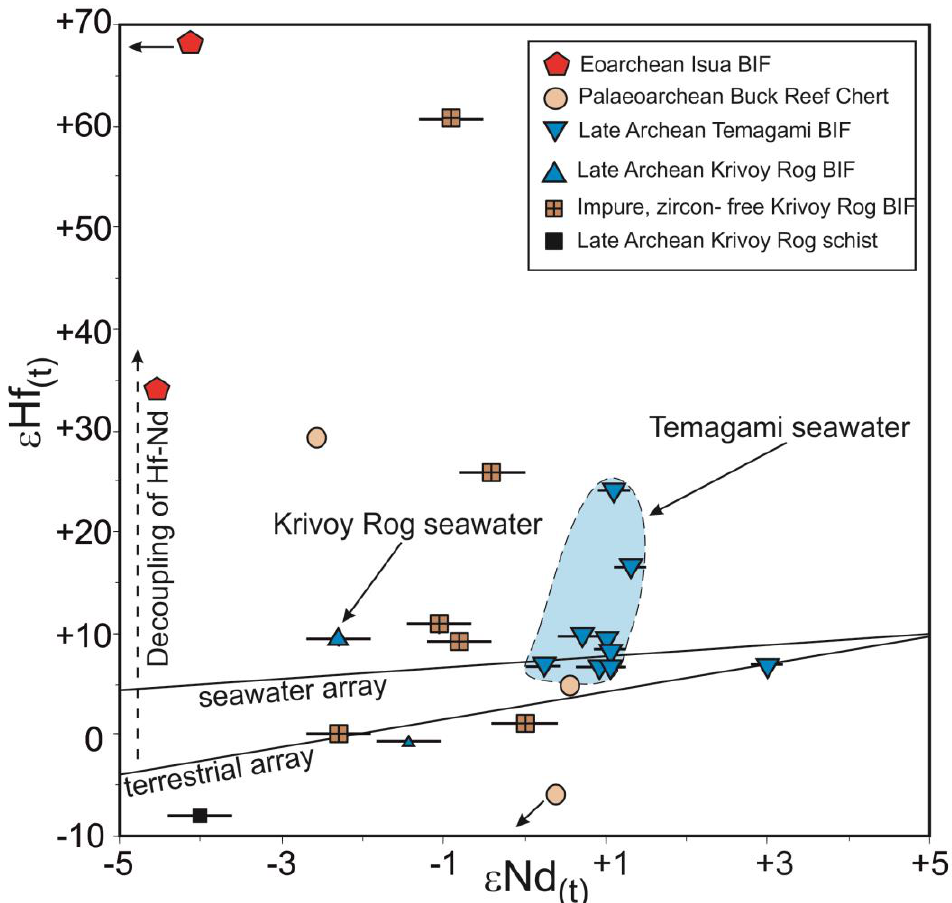
Figure 3. Initial ɛ Nd (t) and ɛ Hf (t) values of Eo-, Meso-, and Neoarchean Banded Iron Formations (BIFs) relative to the seawater and terrestrial arrays and a Krivoy Rog schist. The Hf-Nd isotope systems were already decoupled in the suspended and dissolved fractions of global Late Archean seawater and potentially on local scales during the Meso- and Eoarchean, indicating that emerged, zircon-bearing upper continental crust was available for subaerial weathering and erosion to eventually decouple the Hf-Nd isotopes in the suspended and (truly) dissolved loads of Archean oceans. Data are taken from [8,9,17,21,69,71]. Errors are 2σ and may be smaller than the symbol size.